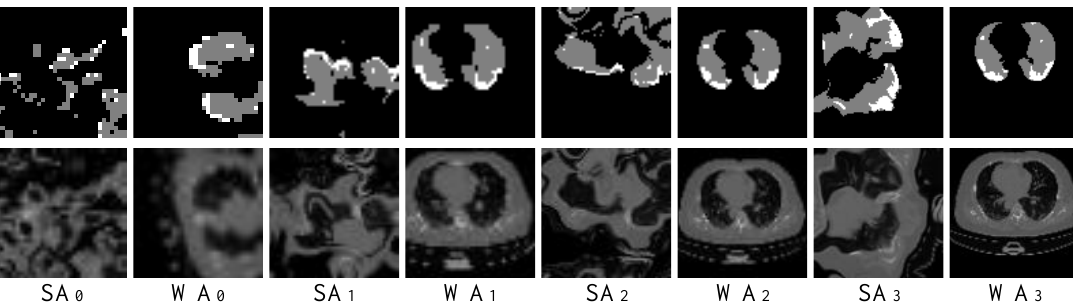
Figure 6. Illustration of augmented images and conditions produced by the hierarchical data augmentation module. SA and WA denote strong augmentation and weak augmentation, respectively. The subscript represents the index of image scale (images are resized for better visualization). The white and gray in condition masks represent the infected regions and lungs,